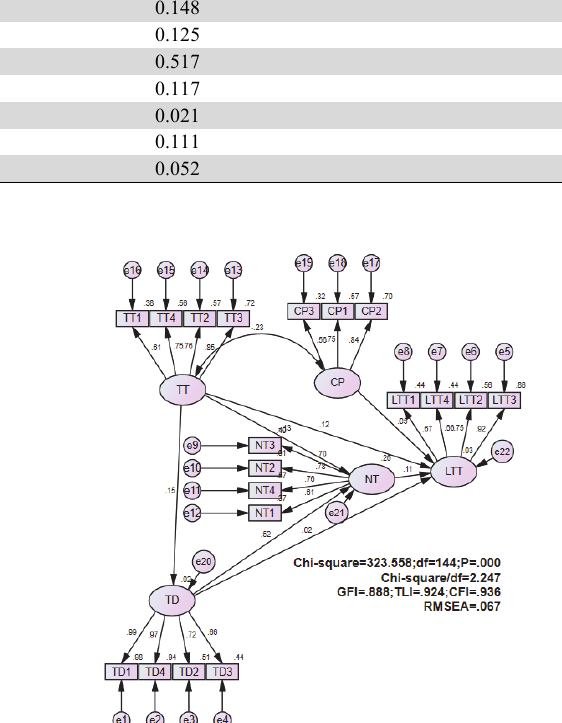
Source: Author’s analytical results, 2019